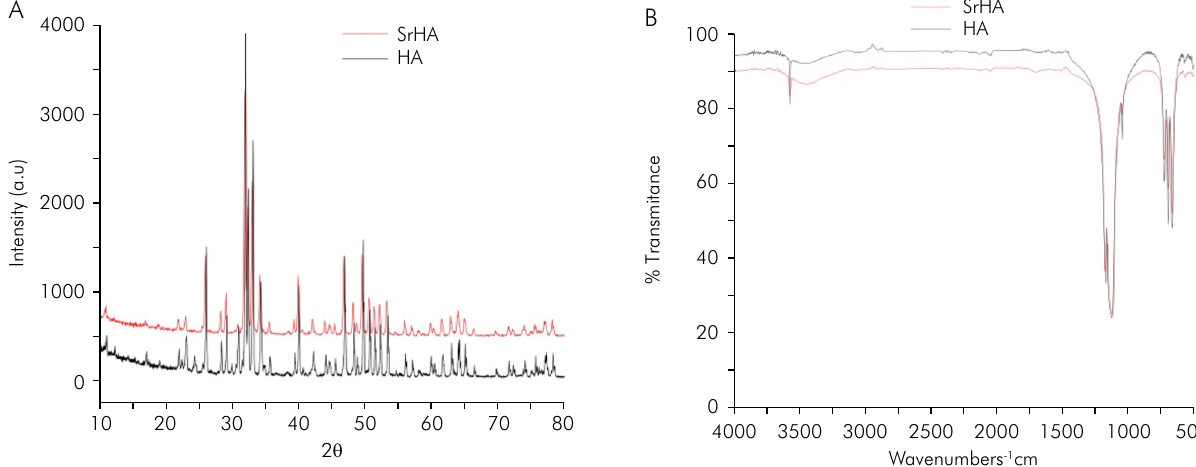
Figure 2. (A) X-ray diffraction (XRD) of SrHA (red) and HA (black) samples. (B) Fourier transform infrared (FTIR) spectra of SrHA (red) and HA (black)